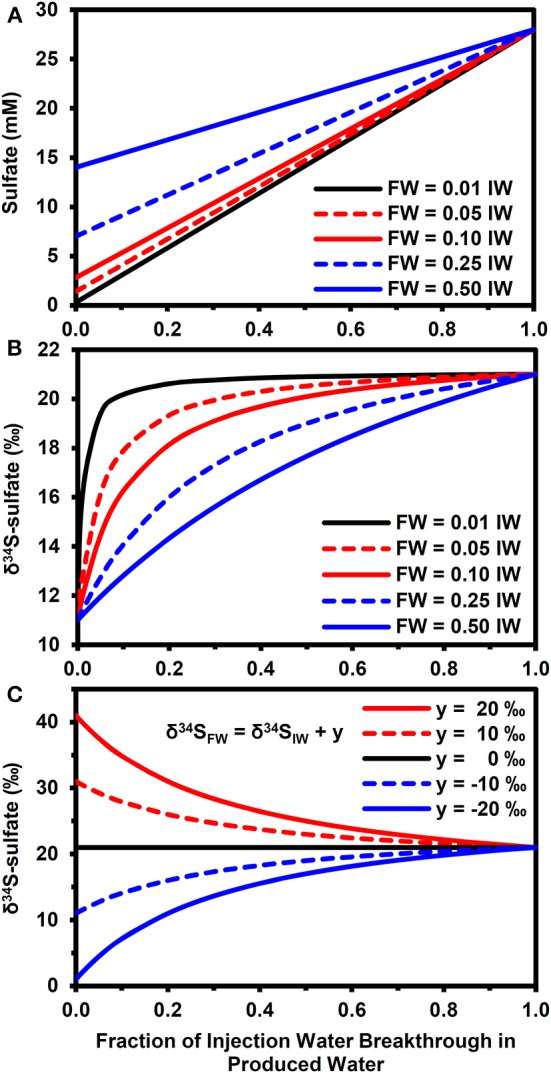
Effect of physical mixing on breakthrough of injection water. (A) Evolution of sulfate concentrations during injection water breakthrough for different formation water compositions (SO4−FW = z.SO4−IW, where SO4−IW = 28 mM and z = 0.01, 0.05, 0.1, 0.2, 0.5). (B) Evolution of δ34S-sulfate for compositions in (A) when δ34SFW = δ34SIW − 10‰ and δ34SIW = 21‰. (C) Evolution of δ34S-sulfate for fixed FW composition (SO4−FW = 0.25.SO4−IW) when δ34SFW = δ 34SIW + y, where y = 20, 10, 0, −10, −20‰.